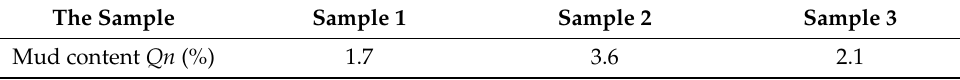
Table 7. Mud content test results of Embodiment